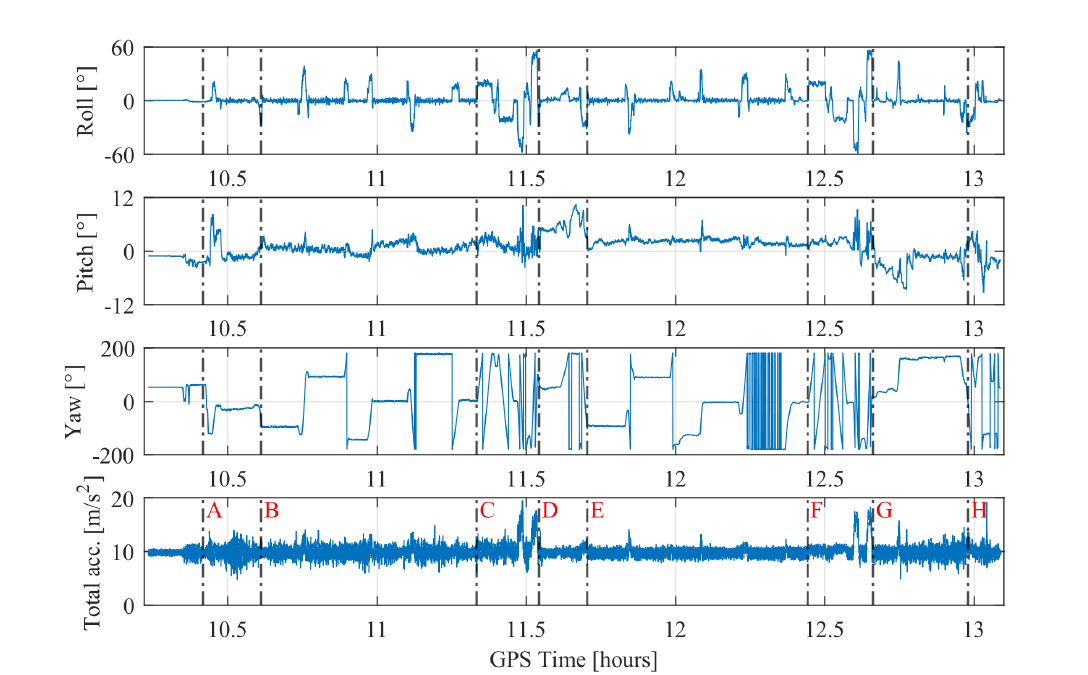
Figure 5. Flight dynamics recorded by the IMU along the whole trajectory. The black dashed line indicates different marked points, which are explained in Table 3. Marked point labels are only inserted in the last subplot but apply to all time